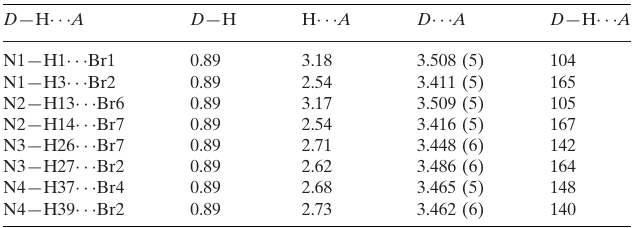
Hydrogen-bond geometry (A˚ , (cid:3)